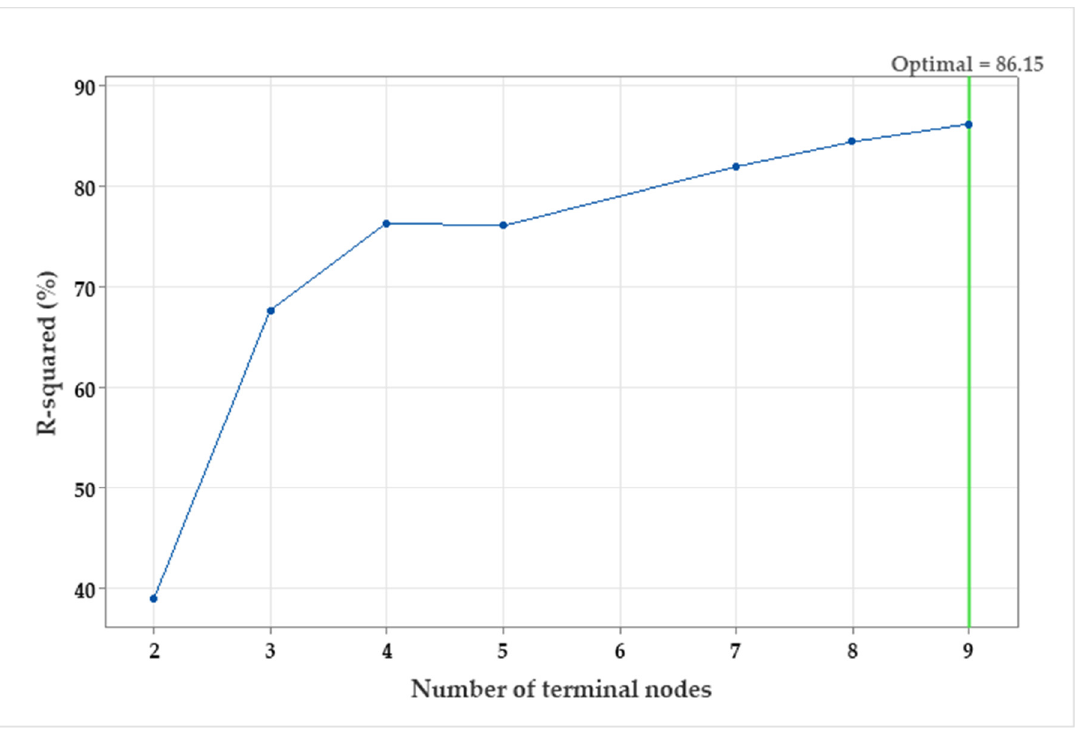
Figure 5. The R 2 vis number of terminal nodes plot generated by a decision tree for pullulan production by A. pullulans .